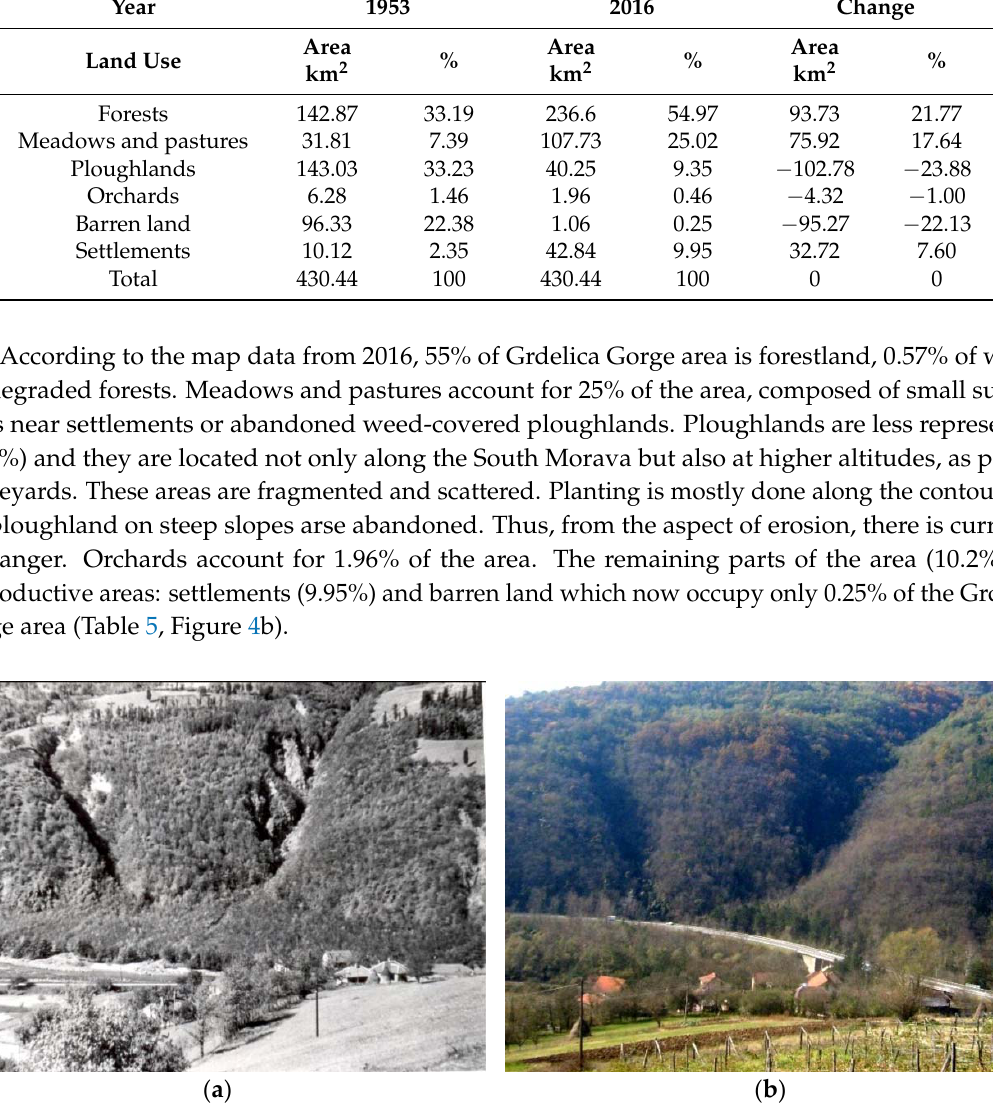
( b ) Figure 5. Soil erosion maps: ( a ) in 1953 [38]; ( b ) in 2016 year. The highest erosion coefficients were registered for the basins of the Jastreba č ka River (Z mean = 1.06), the Palojska River (Z mean = 1.02), the Letoviška River, and parts of the immediate basin of the South Morava with a value of Z mean = 0.96. According to 2016 Erosion map (Figure 5b), 93.64% of the Grdelica Gorge territory was affected by soil erosion of different intensity (403.06 km 2 ). The processes of excessive and intensive erosion (categories I and II) are present in the immediate South Morava Basin. The most frequent are the processes of weak, very weak, and medium erosion (categories IV, V, and III). The values of the erosion coefficient range from Z mean = 0.21 in the watershed of the Bistri č ka River to Z mean = 0.42 in the immediate South Morava Basin (Table 6).